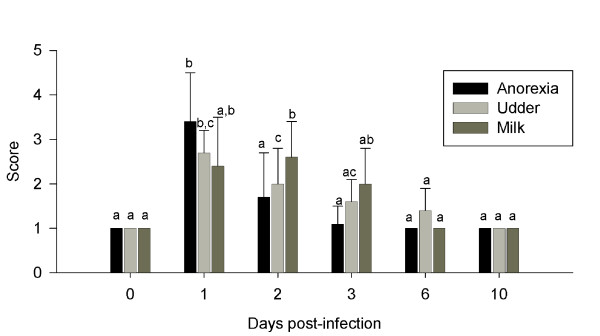
Anorexia, udder and milk appearance. Scaling of anorexia, udder and milk appearance from one day before (day 0) until 10 days after inoculation with E. coli into the udder of 7 dairy cows. Anorexia, udder and milk appearance were scaled ranging from 1 to 4 with 1 being normal and 4 highly affected. Plots with different letters differ significantly. Error bars show SE.